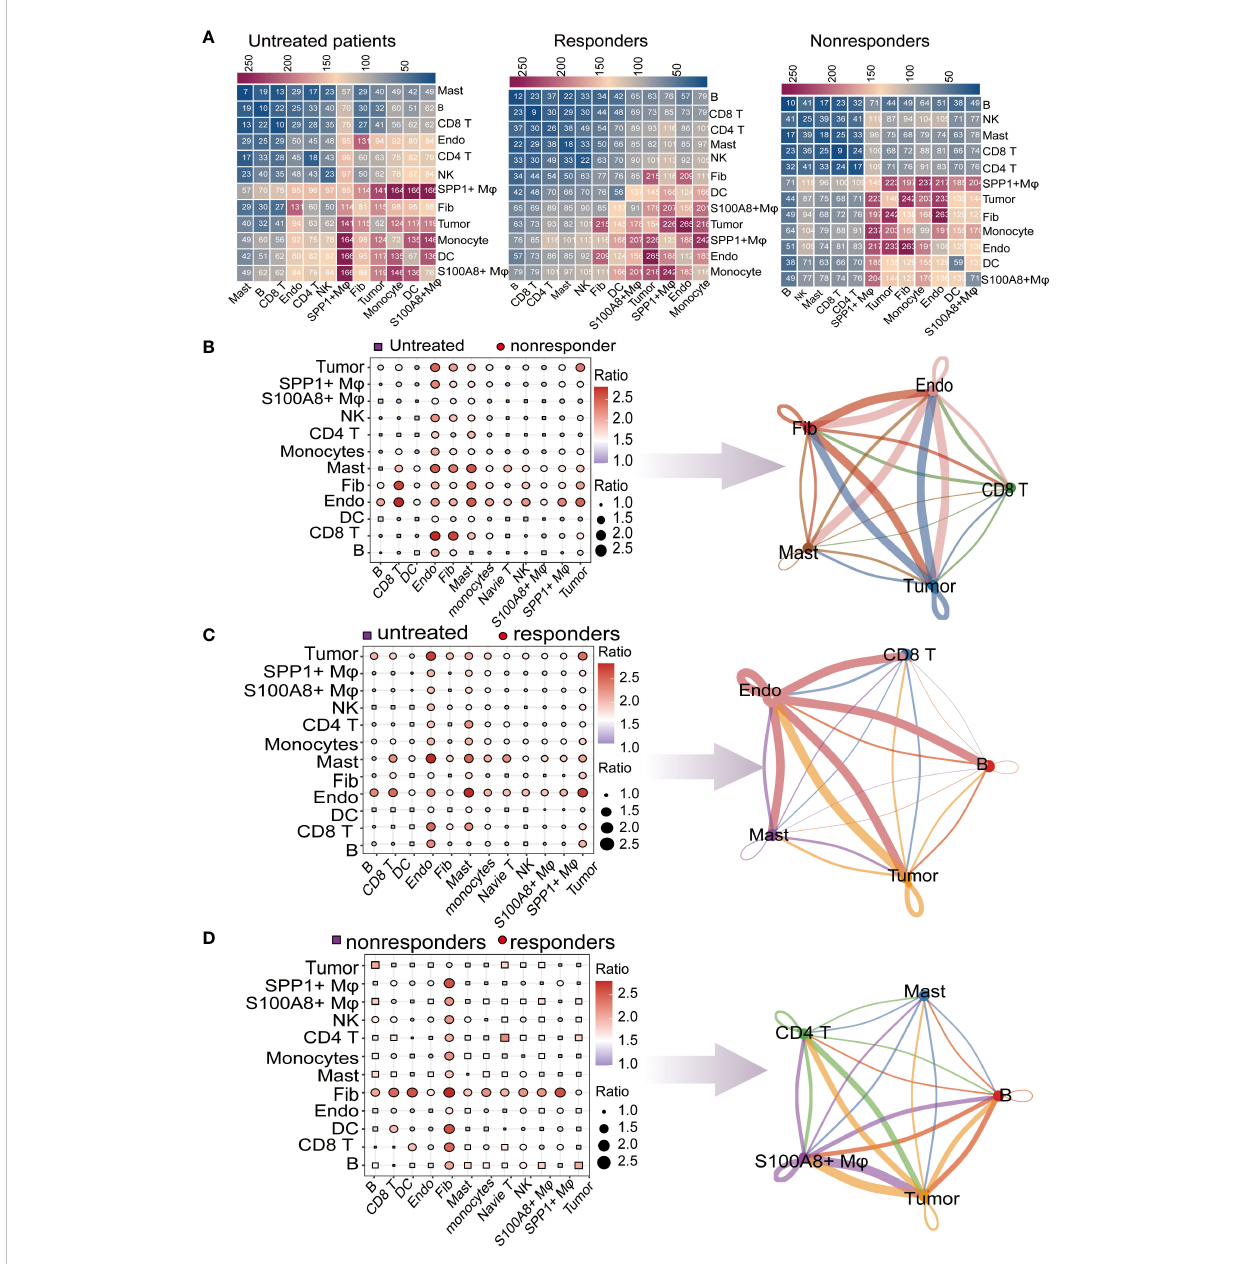
FIGURE 3 Global analysis of ligand – receptor interaction pairs. (A) Detailed network of cell − cell interactions among thirteen cell subsets. Comparison of pretreatment responders and nonresponders. Dot plots depict the changed numbers of putative ligand – receptors in untreated patients compared with nonresponder samples (red, increased; blue, decreased). Cell − cell interactions across all cell pairs in pretreatment responders and pretreatment nonresponders. The top 5 cells with the largest fold change are displayed (B) Comparison of cell − cell interactions between pretreatment responders and untreated patients (red, increased; blue, decreased). The top 5 cells with the largest fold change are displayed (C) Comparison of cell − cell interactions between responders and untreated patients (red, increased; blue, decreased). The top 5 cells with the largest fold change are displayed. (D) Comparison of cell − cell interactions between responders and nonresponders (red, increased; blue, decreased). The top 5 cells with the largest fold change are